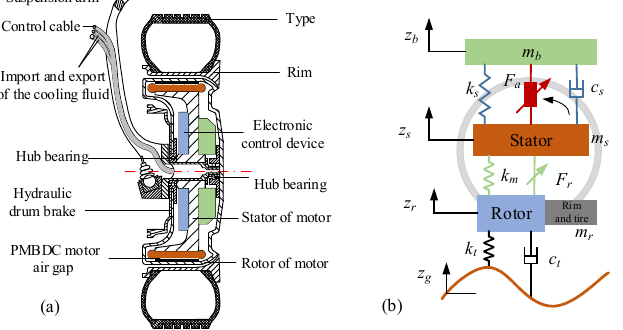
Figure 3. IWM-driven system without a speed reducer. ( a ) Main structure. ( b ) Quarter vehicle